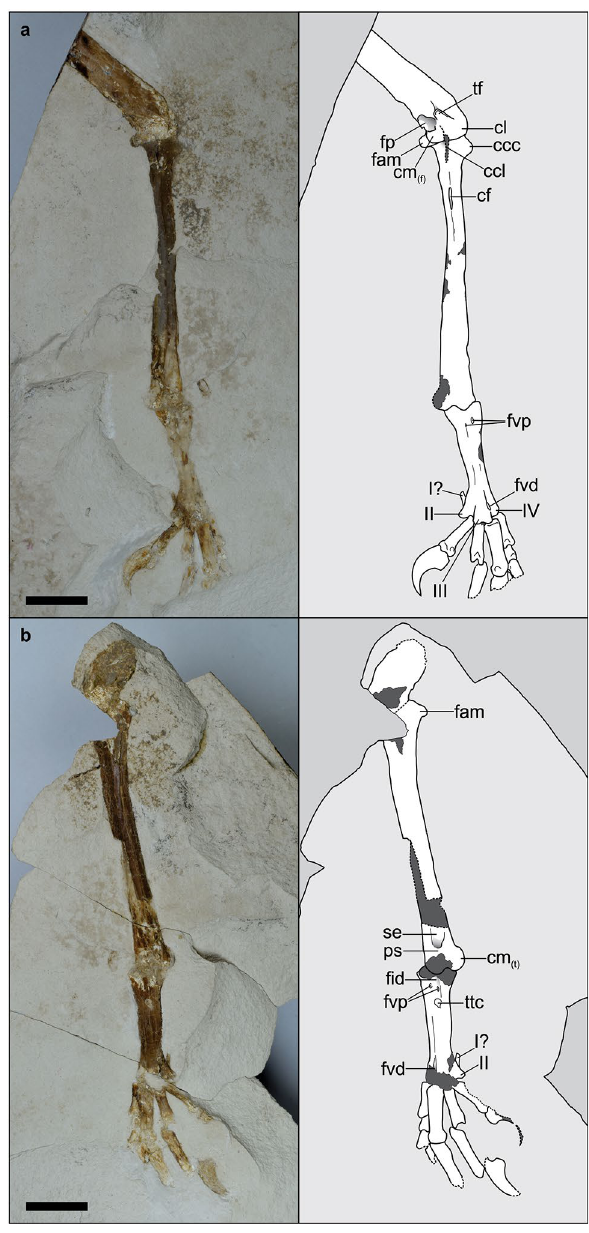
Figure 1. Ueekenkcoracias tambussiae gen. et sp. nov., holotype MPEF-PV 10991. Photograph (left) and interpretative drawing (right) of slabs ( a , b ). ccc crista cnemialis cranialis, ccl crista cnemialis lateralis, cf crista fibularis, cl condylus lateralis, cm (f) condylus medialis (femur), cm (t) condylus medialis (tibiotarsus), fam facies articularis medialis, fid fossa infracotylaris dorsalis, fp fossa poplitea, fvd foramen vasculare distale, fvp foramina vascularia proximalia, I? metatarsi I?, II–IV trochlea metatarsi II–IV, ps pons supratendineus, se sulcus extensorius, tf trochlea fibularis, ttc tuberositas m. tibialis cranialis. Scale = 1